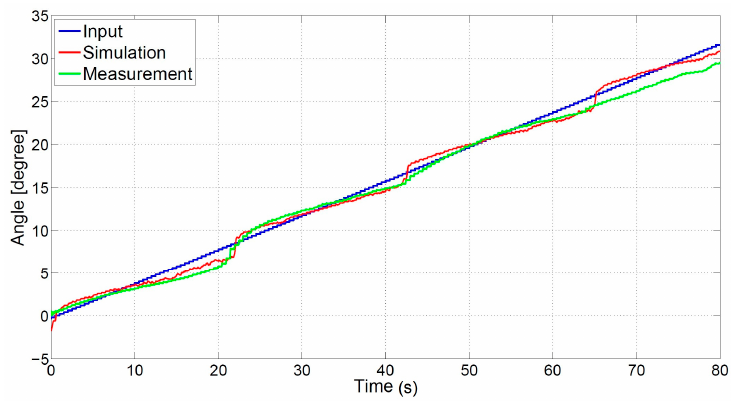
Figure 10. Simulation and real measurement in a positive direction.